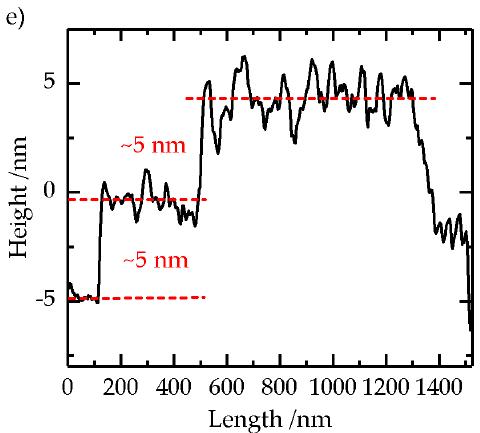
Figure 4. Exemplary TEM images of the self-assembled TiO 2 NP film ( a , b ). Tapping mode atomic force microscope (AFM) images of the TiO 2 NP film transferred by the microcontact printing method onto a Pt/Ir surface ( c , d ). Corresponding height profile ( e ) taken along the white line in ( d ) showing height differences of ca. 5 nm.